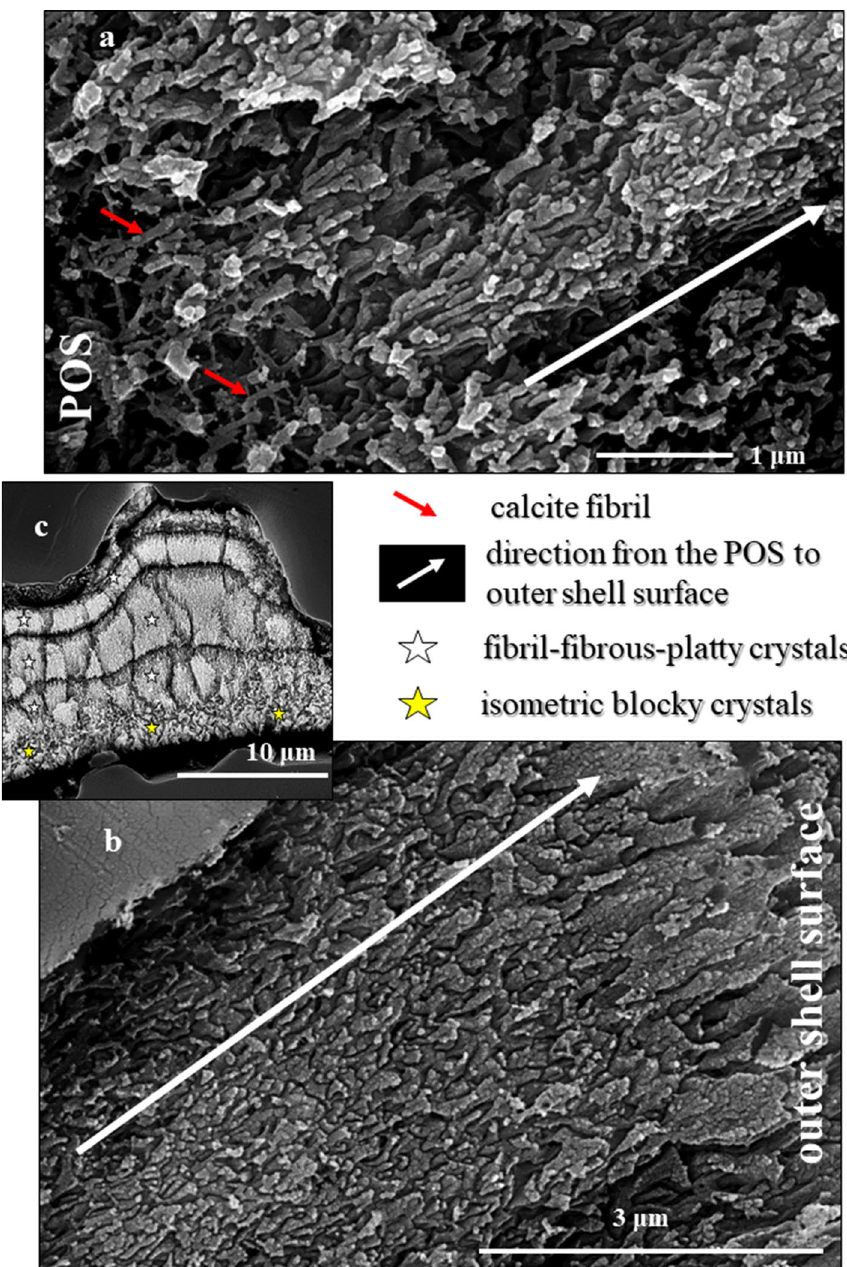
Figure 9. The smooth and steady transformation of crystal morphology and size within a cone-shaped twinned crystal unit; starting with the nanofibrils within the POS (red arrows in ( a )) and developing to the large plate/ blade-shaped crystals at outer shell surfaces ( b ). ( c ) Intercalations of organic substance related to successive chamber formation cycles (undulating black lines) do not interrupt the steady transformation of crystal shape and size, nor the twinning characteristic of the calcite within the cone-shaped units. ( a ), ( b ), ( c ) BSE images of an etched sagittal cross-section through the entire shell wall of Pulleniatina obliquiloculata